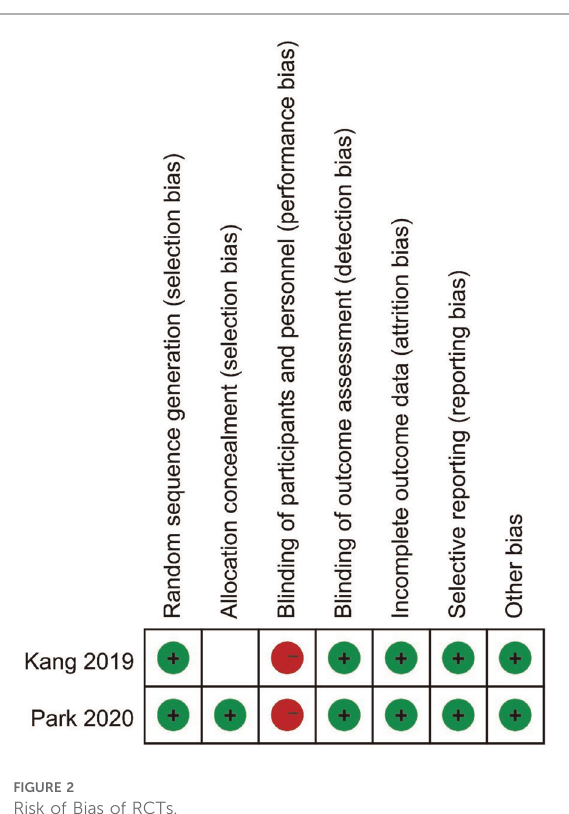
FIGURE 2 Risk of Bias of